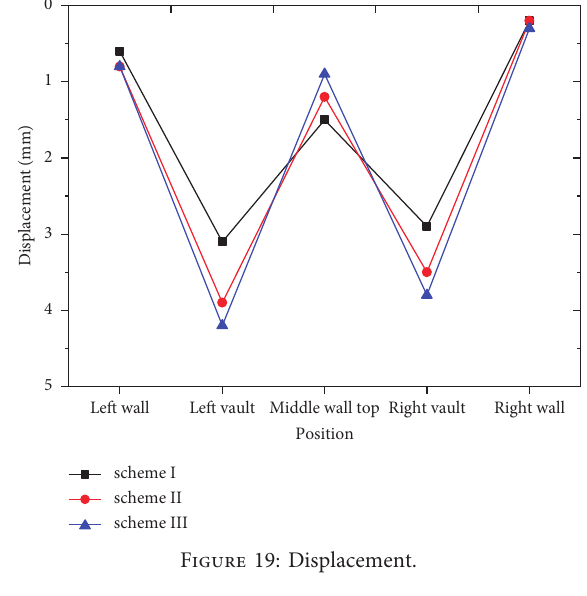
Figure 19: Displacement.